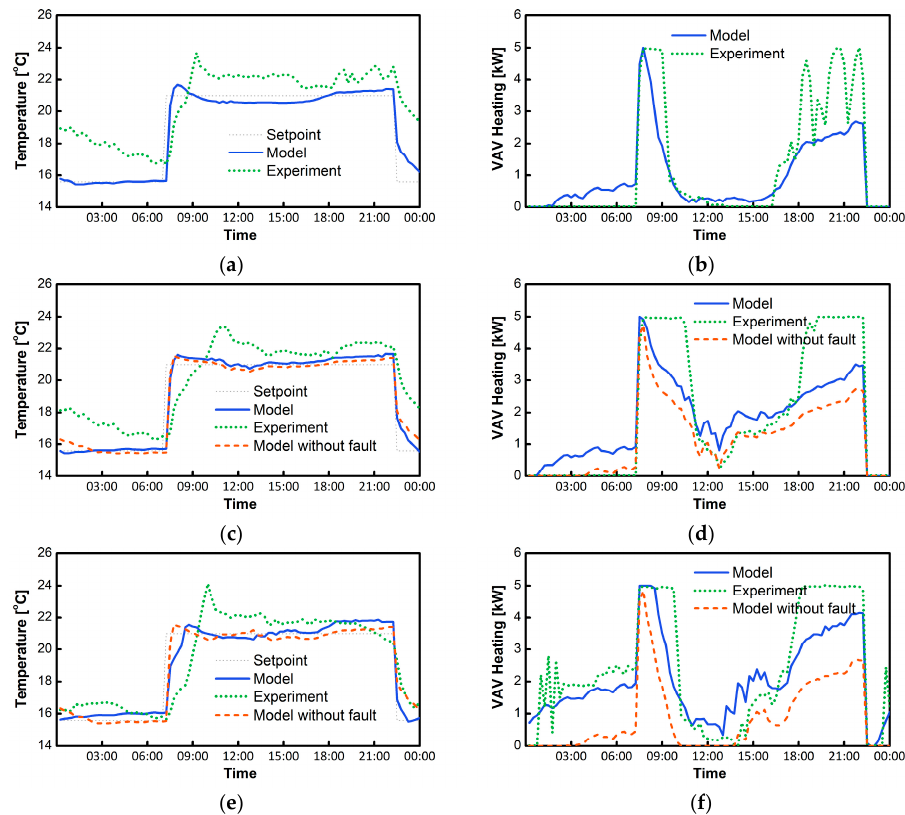
Figure 14. Room temperature and VAV heating power of baseline and faulted scenarios in a smaller room (room 106). ( a ) baseline: Room 106 temperature; ( b ) baseline: Room 106 VAV heating output; ( c ) +20% infiltration: Room 106 temperature; ( d ) +20% infiltration: Room 106 VAV heating output; ( e ) +40% infiltration: Room 106 temperature; ( f ) +40% infiltration: Room 106 VAV heating output.